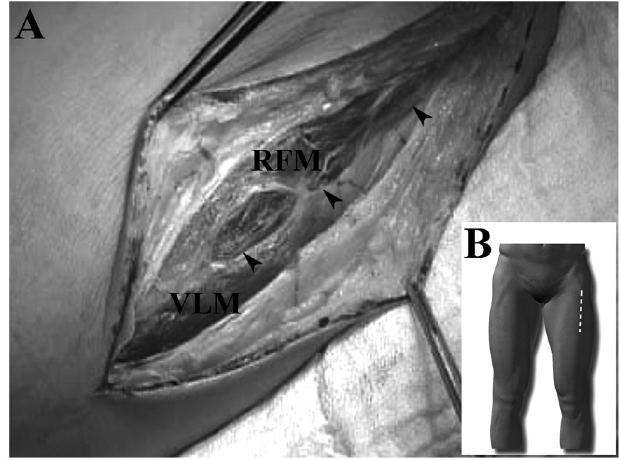
Fig. 1 – Approach of the DLFCA. A: Arrowheads point to the line between the RFM and the VLM where the DLFCA courses downward through the intermuscular space. B: The dashed white line indicates the initial incision, which was 15 to 20 cm in length on the anterolateral aspect of the thigh in its proximal and middle third in the lateral margin of the RFM. DLFCA = descending branch of the left femoral circumflex artery; RFM = rectus femoris muscle; VLM = vastus lateralis